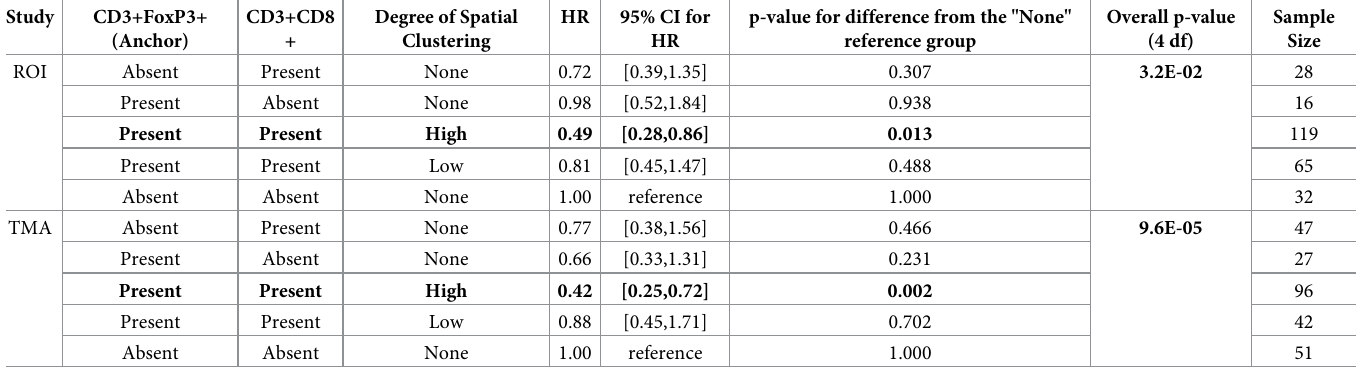
Table 3. Results of co-localization/co-clustering of CD3+CD8+ (cytotoxic T-cells) and CD3+ FOXP3+ (regulatory T-cells) using bivariate Ripley’s K for the ROIs and TMAs. Degree of spatial clustering based on permutation-based estimate of CSR. Models were adjusted for age at diagnosis and stage. The no cytotoxic T-cells and no regulatory T-cells (none) group/category is the reference group. The overall p-value is the joint association of the five categorial variable based on immune abundance and spatial clustering on overall